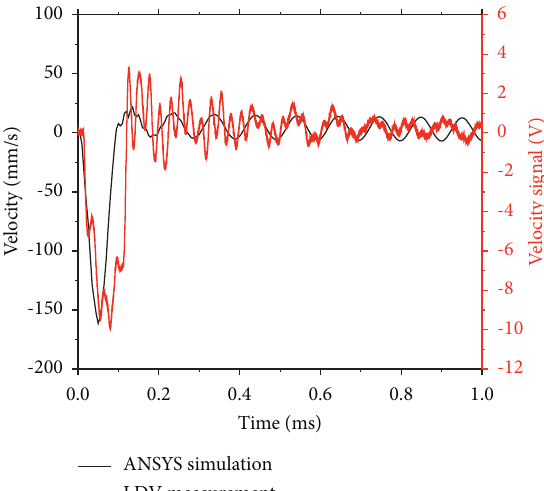
Figure 9: Time-dependent velocity signal at the rear side ( x � y ≈ 0, z � 0.5) of a 0.5mm-thick h-BN disc from LDV measurements at an accumulated fluence of 1 × 10 13 ions/cm 2 (red) and simulated with ANSYS using pristine properties (black).